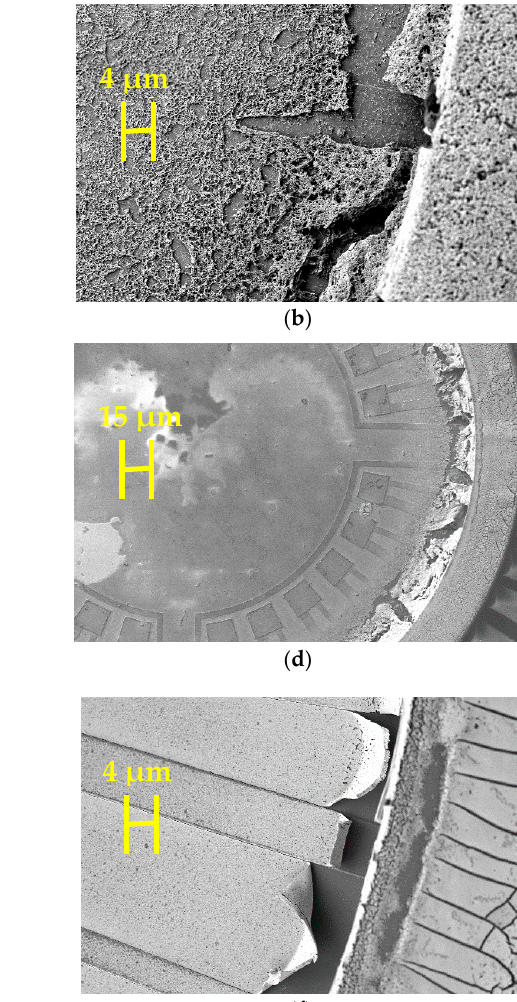
( a ) Pt-PDA; ( b ) Pt-DATER; ( c ) PT-BEN; ( d ) Pt-DAN; ( e ) Pt-DACH; ( f ) Pt